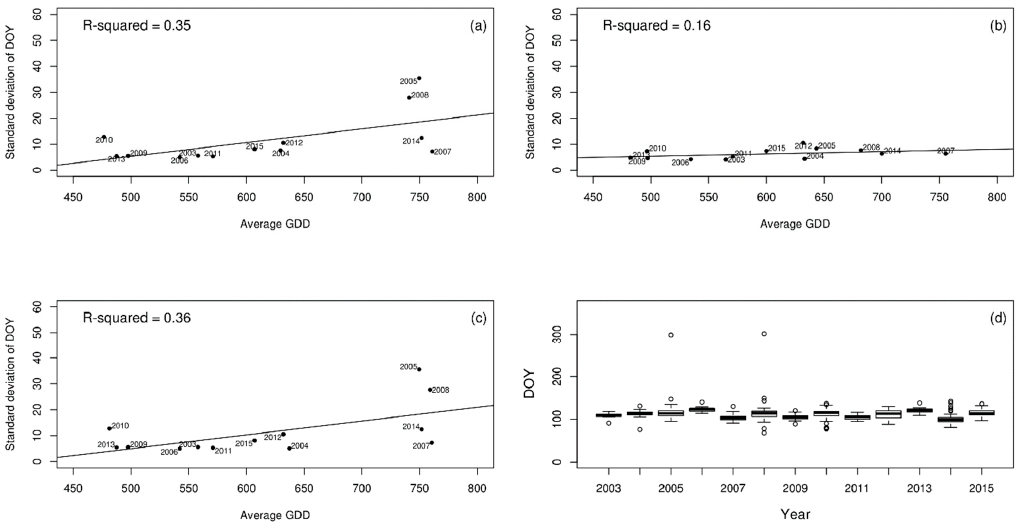
Figure A11. Pedunculate oak leafing onset synchrony models for ( a ) original, ( b ) outlier-free and ( c ) consistent observations. Panel ( d ) shows annual boxplots of the reported DOYs for the original observations.